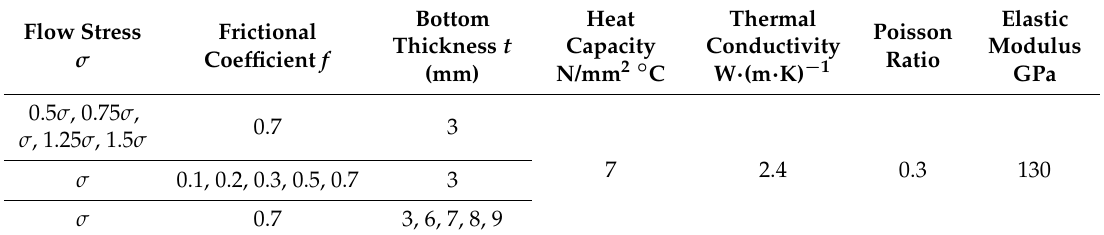
Table 2. Material parameters of the TiBw/Ti6Al4V composite for finite element modeling.